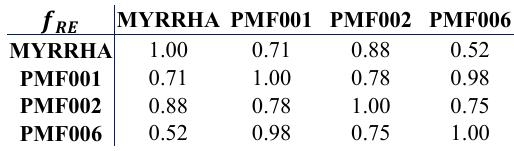
Table 3. Representativity factor of the experiments used in the assimilation.